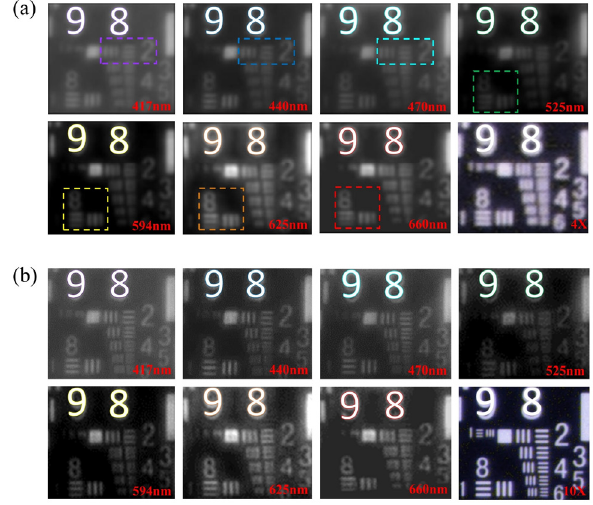
Figure 17. Experimental singlet multi-spectral microscopy by a sample of USAF-target resolution plate [107]. ( a ) Sub-picture 1–7 immediately imaged by singlet MSM with 7 wavelength, and sub- picture 8 was imaged by commercial microscope with 4X objective. ( b ) Sub-picture 1–7 recovered by deep learning algorithm with 7 wavelength, respectively; and sub-picture 8 was imaged by commercial microscope with 10X